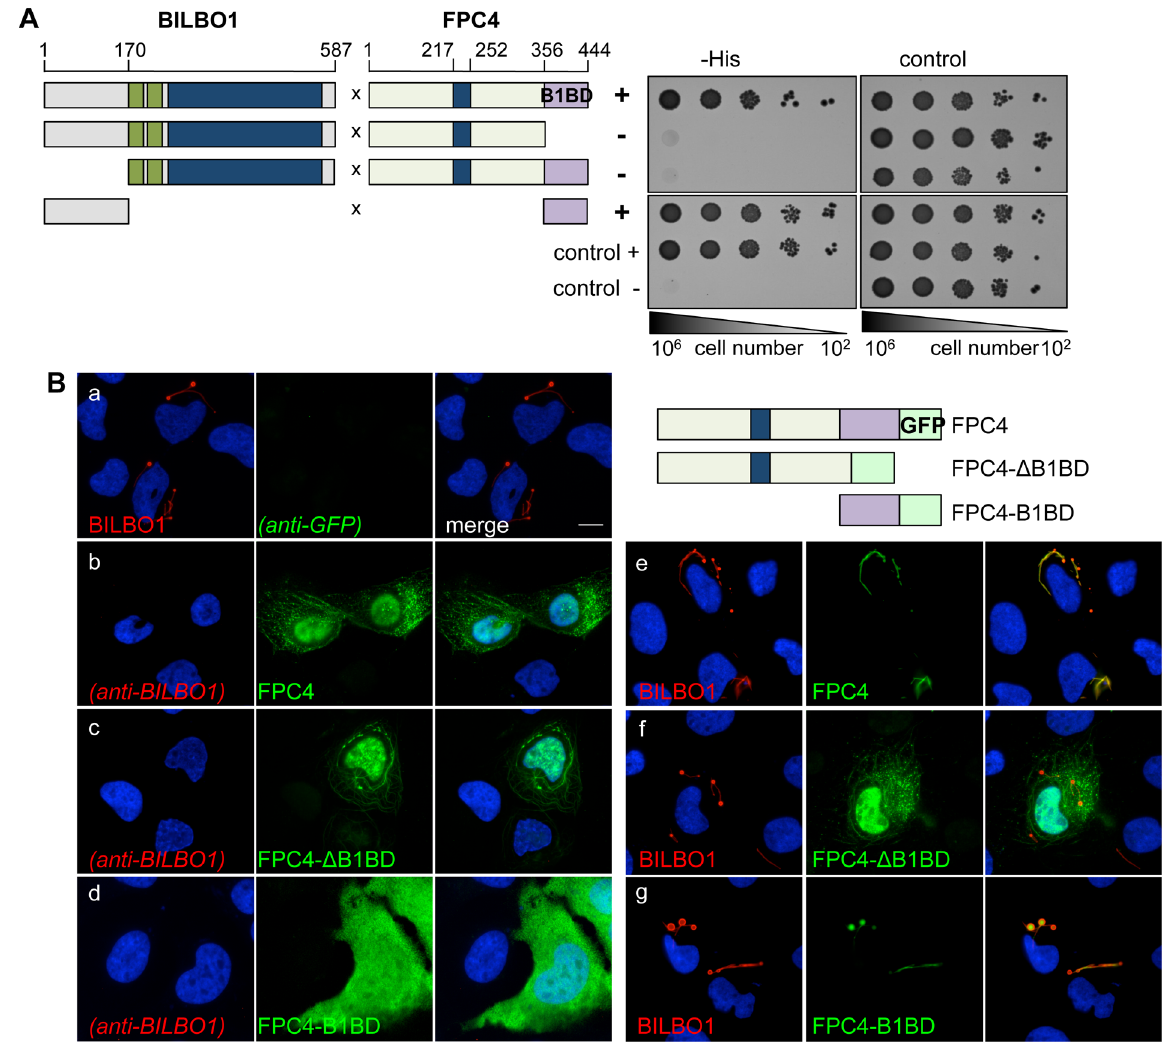
Fig 1. BILBO1—FPC4 interaction involves their N-terminal and C-terminal domains respectively. (A) BILBO1-FPC4 yeast two- hybridinteractiontest. Left panel:Schematic overviewof BILBO1 and FPC4 domainsand of the combinations tested by Y2H. The EF-hand calcium bindingsites of BILBO1 are representedin green and the coiled-coil domainsin BILBO1 and FPC4 are represented in blue. The FPC4 B1BD is represented in violet. Right panel: The interactionstested were probedon–histidineselective medium (-His) and on growth control medium (control) (n = 3). Positive control involvedp53 and T-antigen, whereasnegative control involved Lamin and T-antigen.(B) Heterologous expressionand co-expression in U-2 OS cells of FPC4 and FPC4 truncations fused to a C- terminalGFP tag, and of BILBO1. BILBO1 (a), FPC4 (b), FPC4- Δ B1BD(c) and FPC4-B1BD(d) were expressedalone and cells were probedwith anti-BILBO1 (red) and anti-GFP (green). In e, f, g, cells were expressingBILBO1 + FPC4, BILBO1 + FPC4- Δ B1BD, and BILBO1 + FPC4-B1BD respectivelyand were also probedwith anti-BILBO1 (red) and anti-GFP (green). Cells were extracted before labelling,except in (d) to show the cytoplasmic localisationof FPC4-B1BD, which is not visibleon extracted cells. The transfections were performed more than three independenttimes. Nuclei were DAPI stained (blue). Scale bar represents10 μ